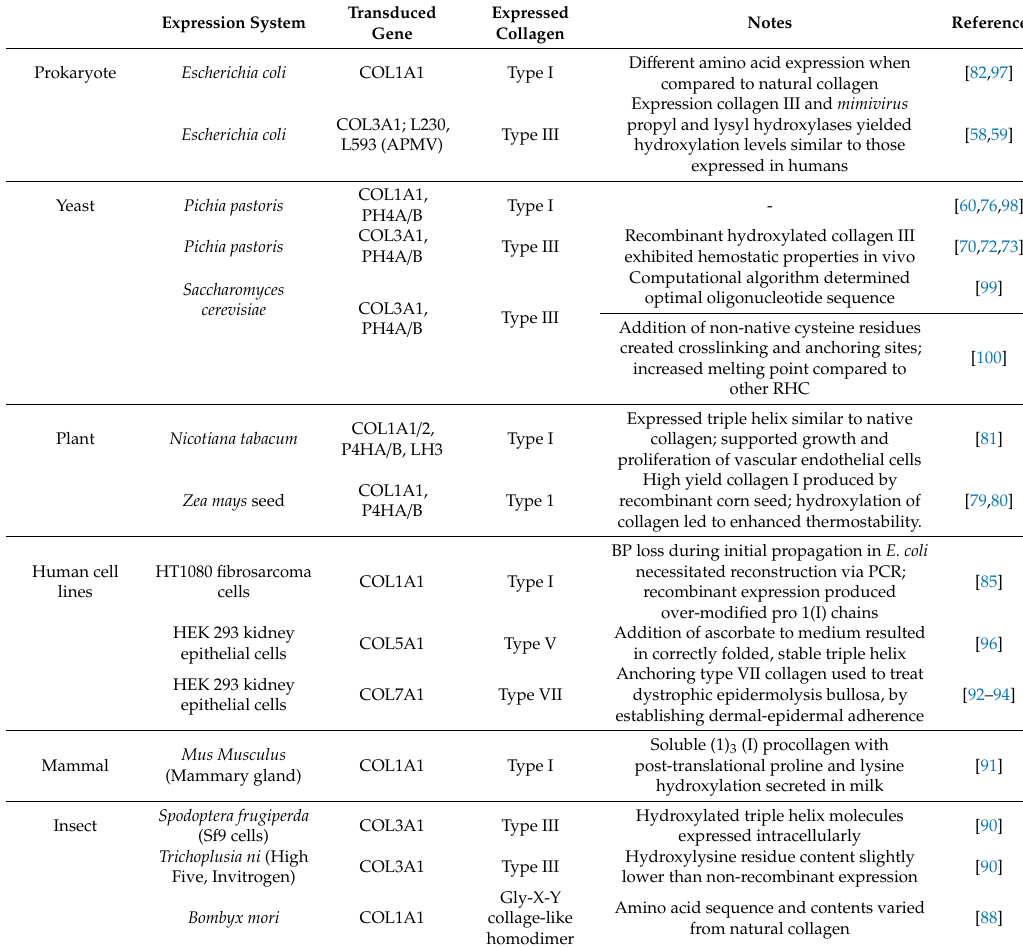
Summary of recombinant expression systems, with notes indicating variation from mammalian-derived collagen, methodological issues, and potential